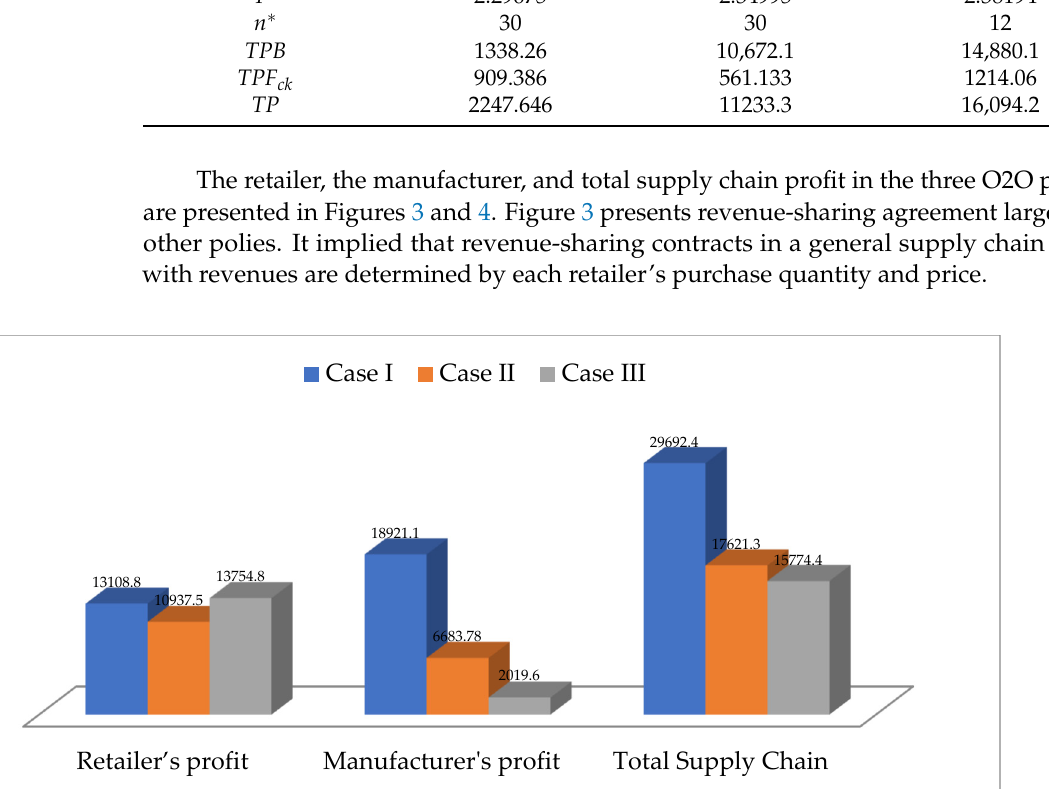
Figure 4. Offline situation measures under three policies. 7.2. Sensitivity Analysis To perform data analysis, the relative contributions of these parameters ( ck g